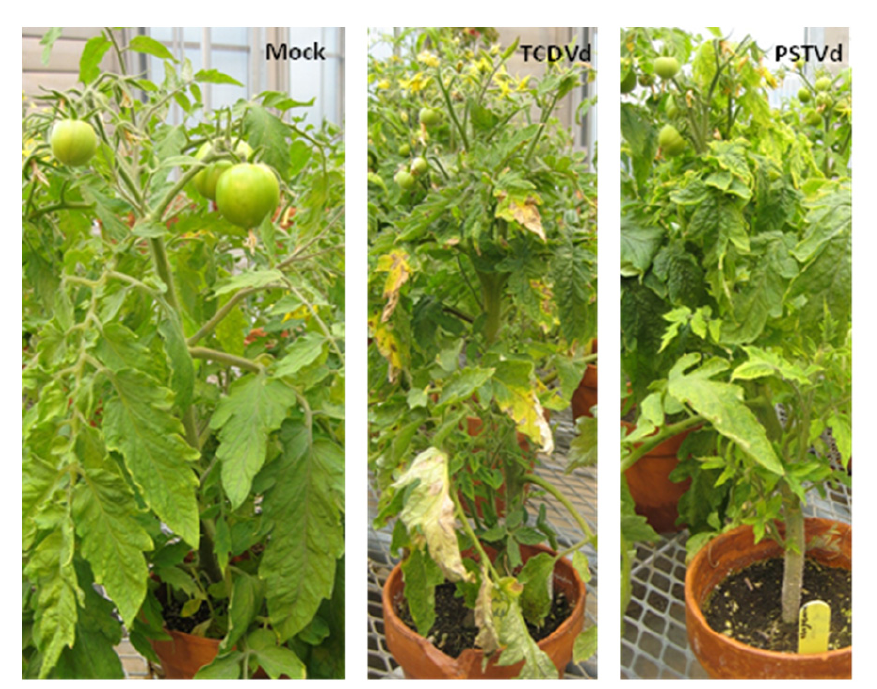
Figure 1. Symptoms induced by Tomato chlorotic dwarf viroid (TCDVd) isolate Trust and Potato spindle tuber viroid (PSTVd) isolate FN in tomato plants. Tomato (cultivar Sheyenne) plants at the four-leaf stage were mechanically inoculated with TCDVd or PSTVd (leaf extract from an infected tomato plant) or buffer (Mock) and grown in the greenhouse. Pictures shown were taken 45 days after